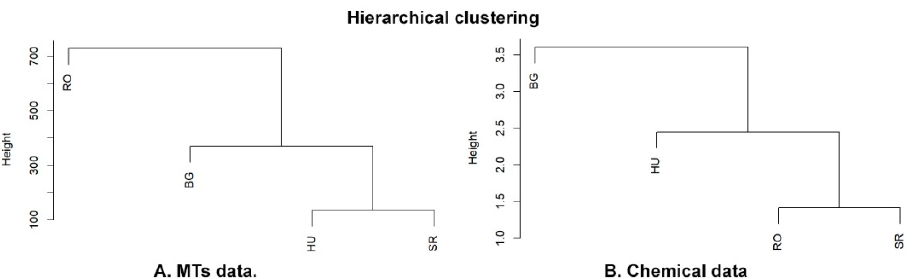
Figure 8. Dendrograms depicting the hierarchical clustering of MT data ( A ) and phytochemical data ( B ), respectively.